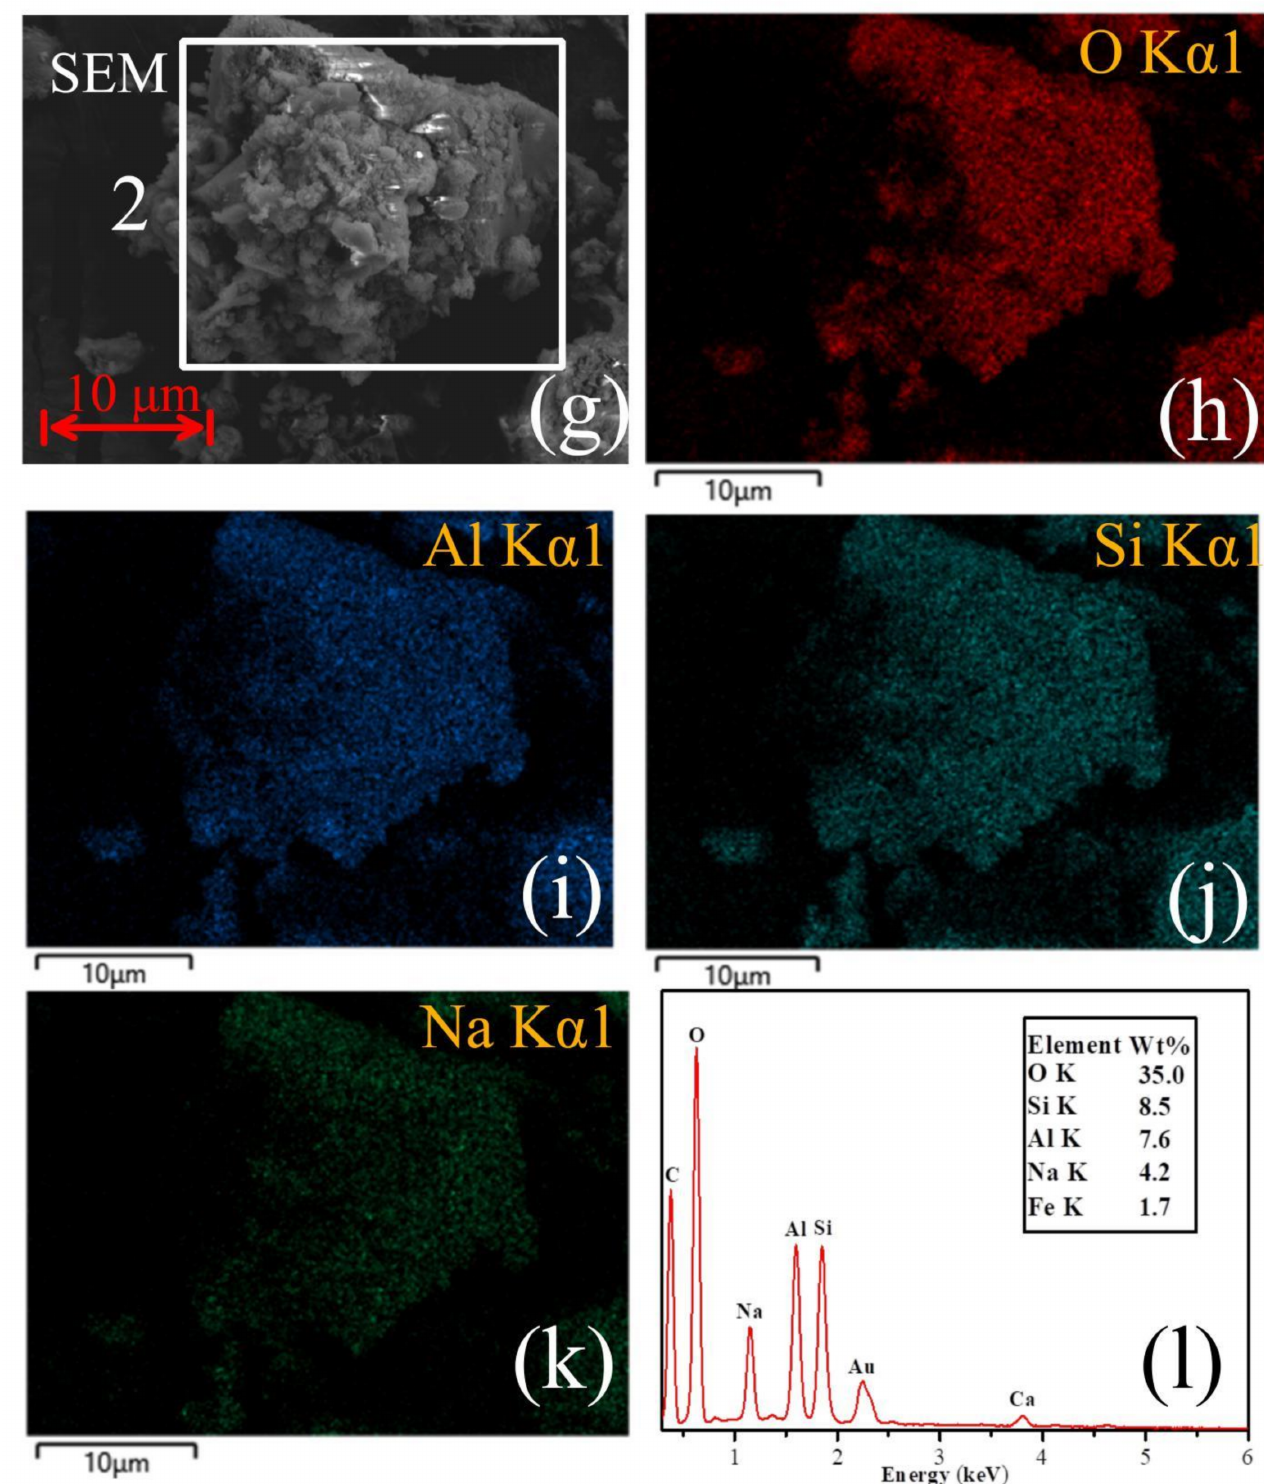
Figure 9. ( a ) SEM images obtained from the raw CFA, ( b ) O distribution map of the area 1, ( c ) Al distribution map of the area 1,( d ) Si distribution map of the area 1, ( e ) Fe distribution map of the area 1, ( f ) EDS X-ray spectrum from Figure 1 ( a ) area. ( g ) SEM images obtained from the sample S4-4, ( h ) O distribution map of the area 2, ( i ) Al distribution map of the area 2, ( j ) Si distribution map of the area 2, ( k ) Fe distribution map of the area 2, ( l ) EDS X-ray spectrum from Figure 1 ( g )